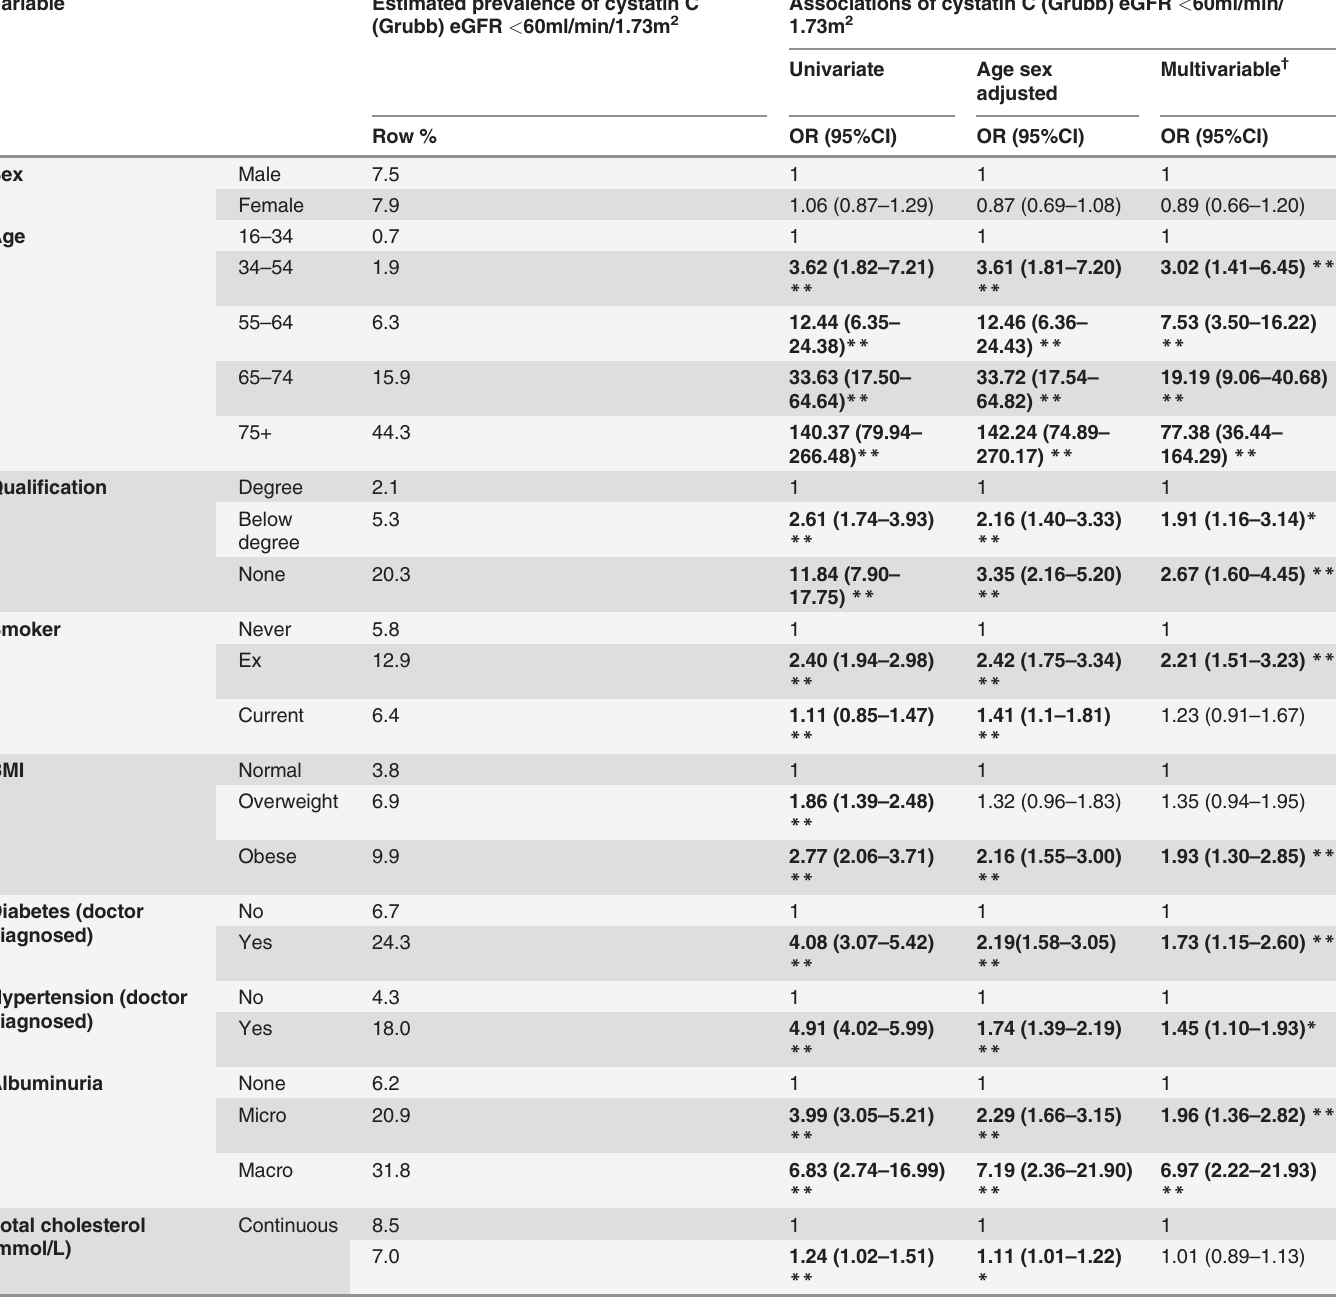
Table 4. Estimated prevalence and associations of cystatin C CKD 3 – 5 (Grubb-de fi ned eGFR < 60ml/min/1.73m 2 ) with socio-economic and clinical factors.